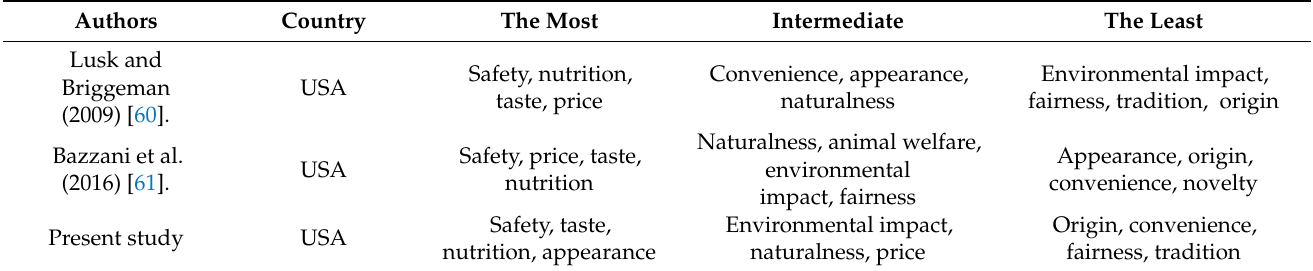
Table 2. Comparative Importance of Food Values in the Literature.